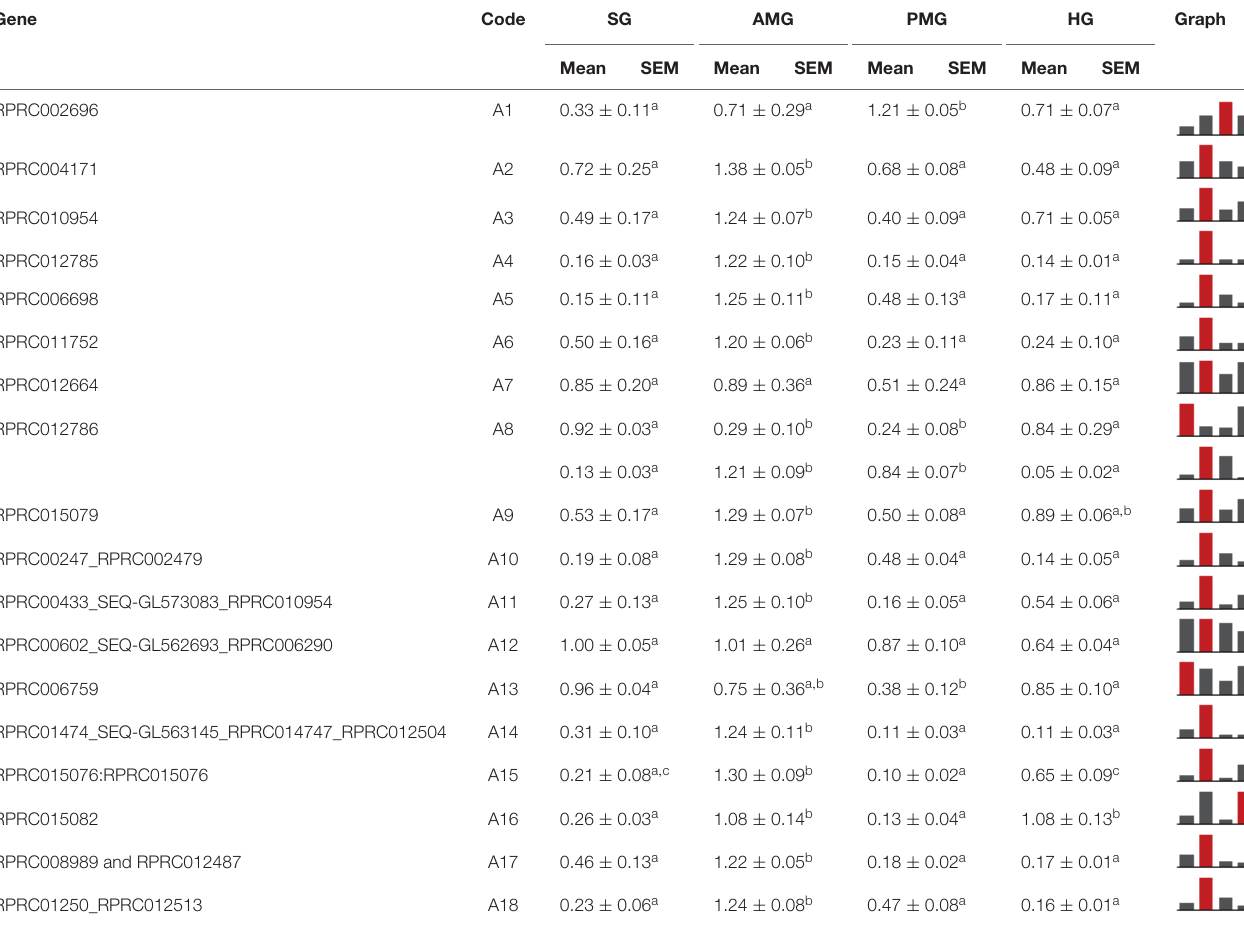
TABLE 1 | Relative expression patterns of genes from protease family A1 in the tissues of Rhodnius prolixus adult males. Gene Code SG AMG PMG HG Graph